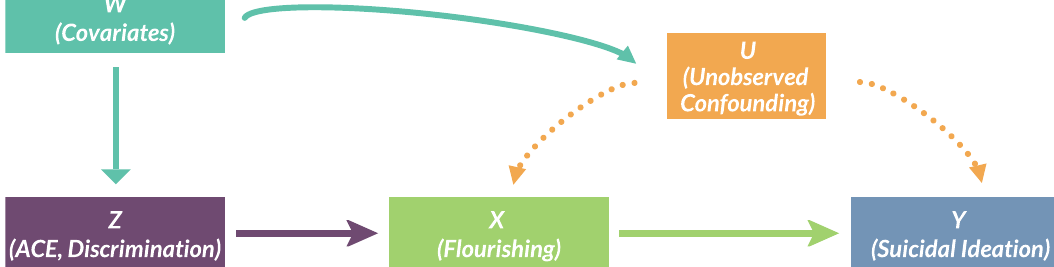
Figure 1. Directed Acyclic Graph.The relationship between flourishing, X, and suicidal ideation, Y, can be estimated using our set of conditional instruments (ACEs, daily discrimination), Z, that are valid conditional on included covariates, W. Y (suicidal ideation) was measured after X (flourishing). W includes severe psychological distress, depression, anxiety, chronic pain, a set of five inflammatory markers, substance use,